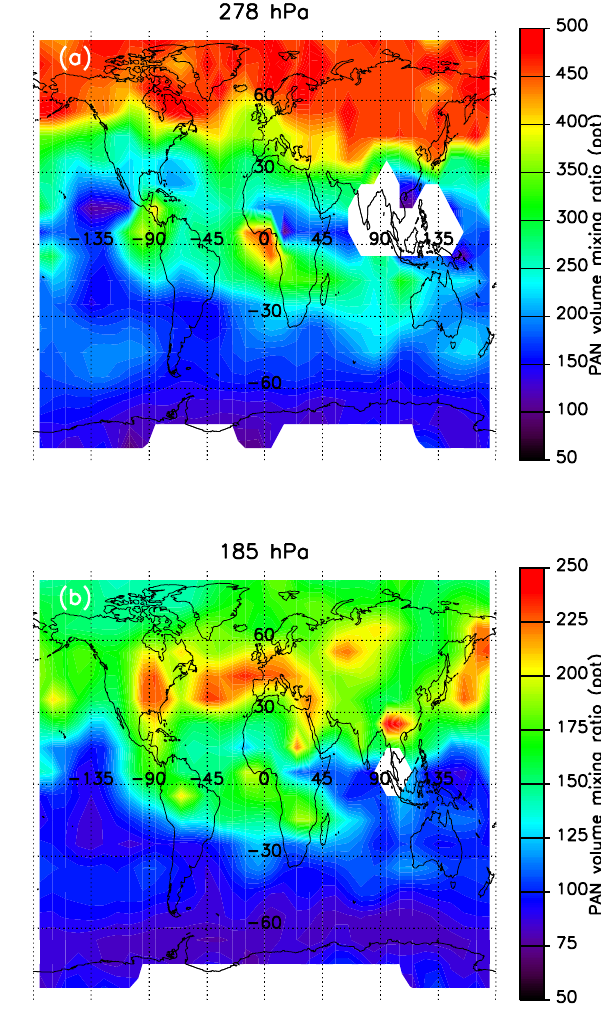
Fig. 8. Global PAN distributions (in units ofpptv) at average pres- sure levels of 278hPa (a) and 185hPa (b) averaged for the month of August 2003. White areas are cloud contaminated regions.